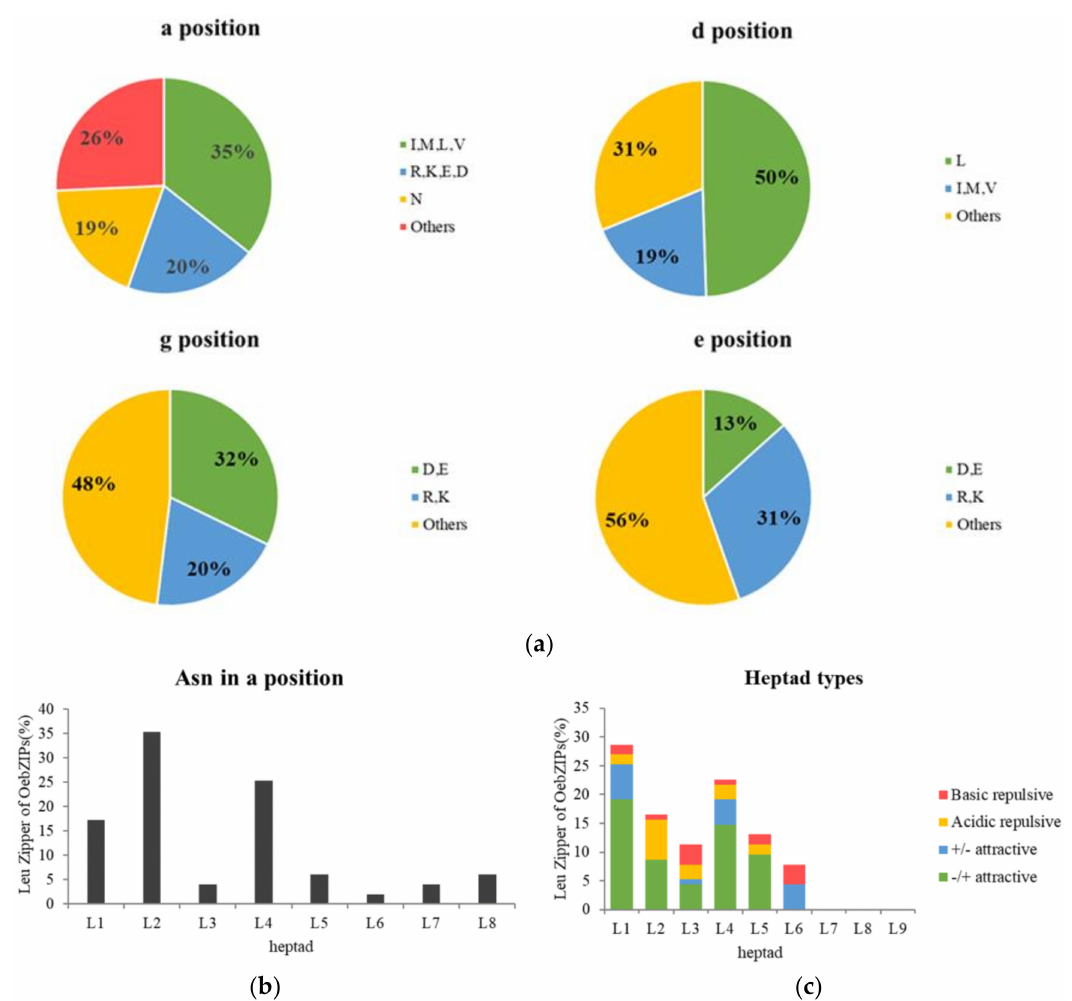
Figure 6. Prediction of the dimerization properties of OebZIP proteins. ( a ) Pie charts depicting Figure 3 for the amino acid positions within the Leu zipper regions. ( b ) Histogram of the frequency of Asn residues present at the position of each heptad within the Leu zippers for the OebZIP proteins. ( c ) Histogram of the frequency of attractive or repulsive g ↔ e (cid:48) pairs per heptad within Leu zippers for OebZIP